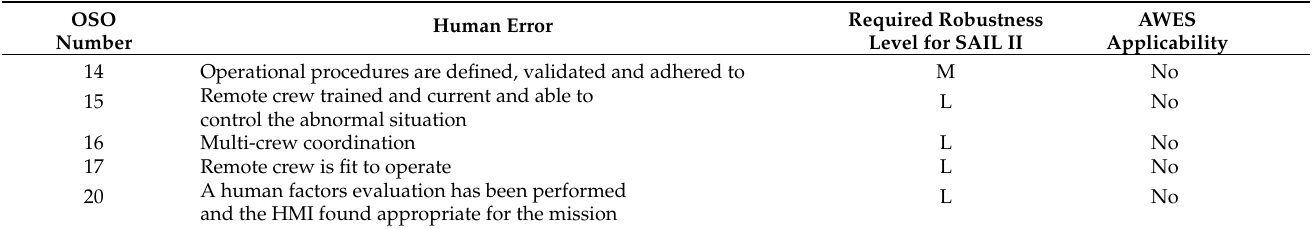
Table 12. Recommended operational safety objectives (OSO) in the SORA and their applicability to commercial AWES, compiled from [20].